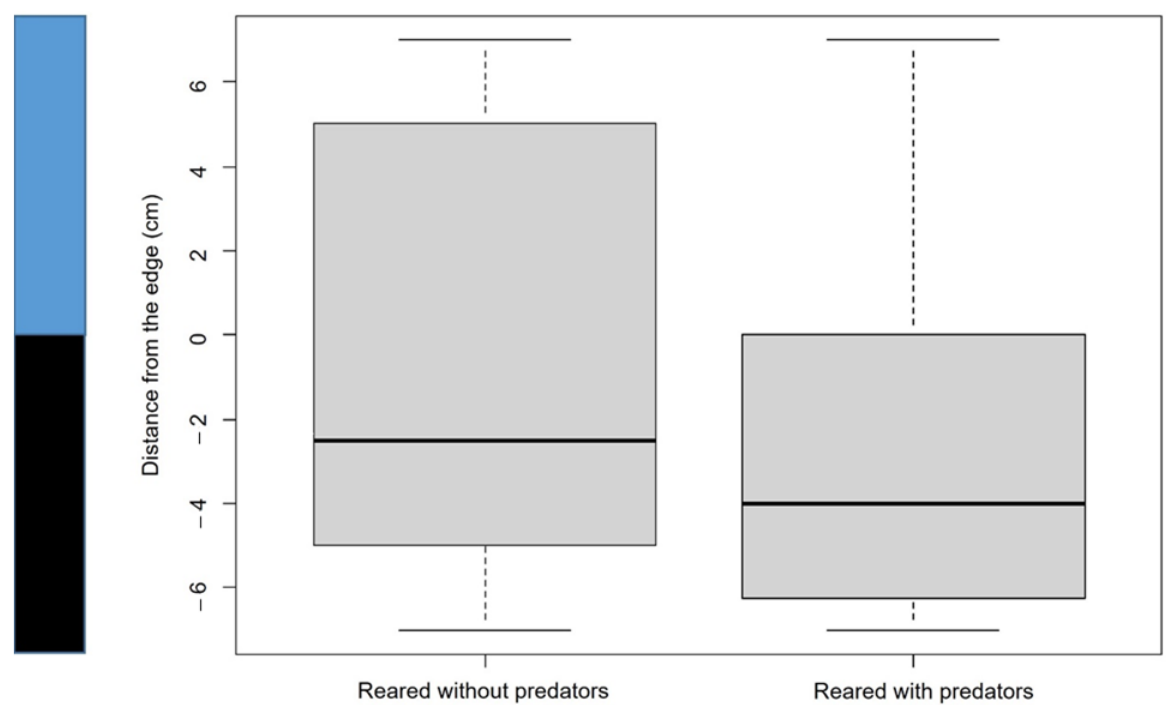
Figure 4. Box–whisker plot of the relationship between the distribution of N. thuringius during the behavioral tests and their condition of rearing (with or without predators). Values of the disposition of individuals are assessed in relation to the center of the arena corresponding to 0. Negative values indicate an arrangement towards the covered half of the arena, whereas positive values indicate an arrangement towards the uncovered half of the arena.